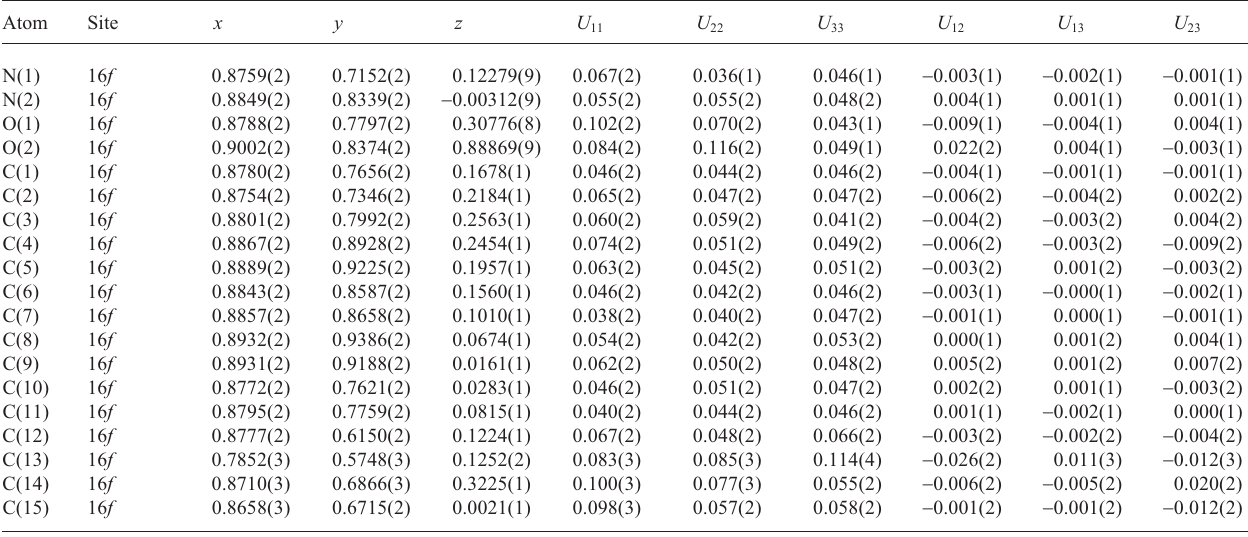
Table 3. Atomic coordinates and displacement parameters (in Å 2 )